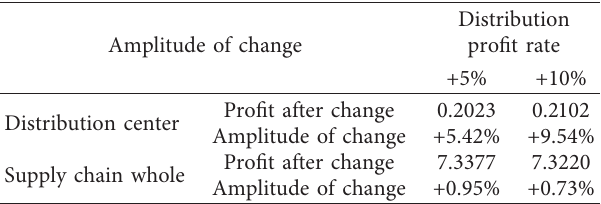
Table 8: Sensitivity analysis results-changes in distribution